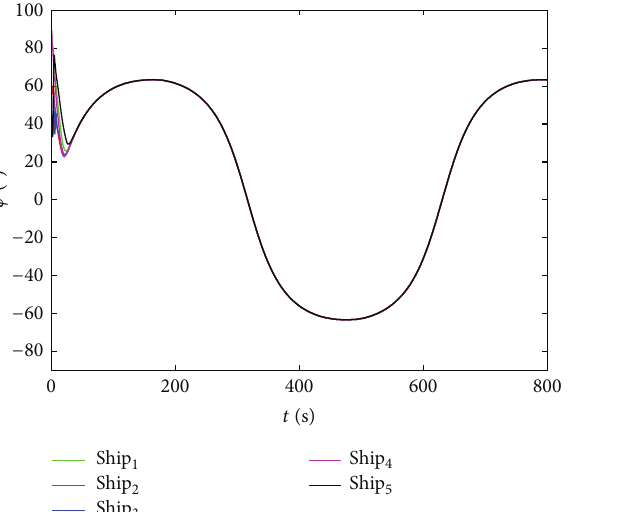
Figure 3: The heading curve of each vessel.